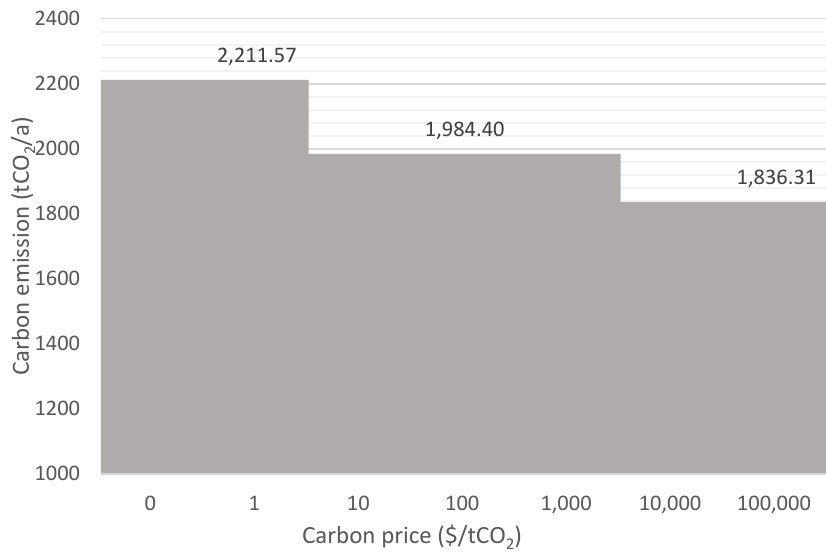
Figure 5. Carbon emissions of optimal planning schemes under different carbon prices.